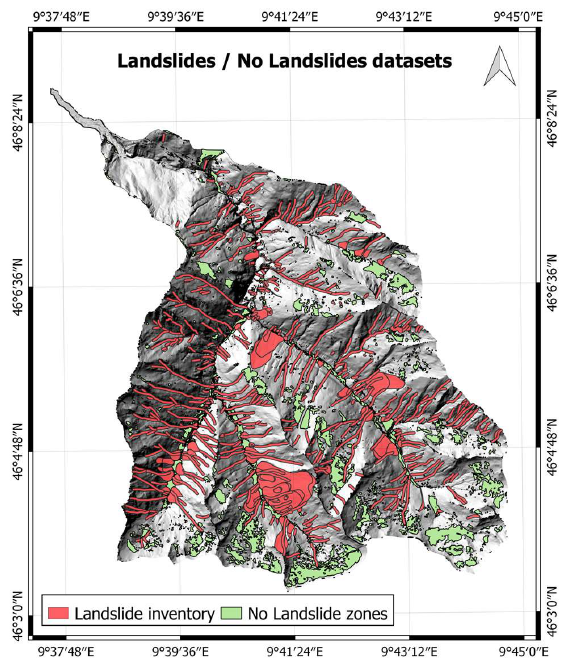
Figure 2. Input datasets for the training/testing the